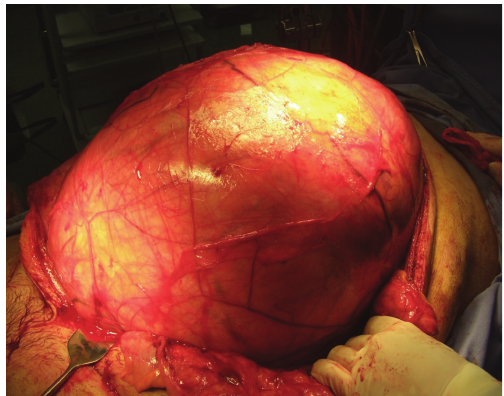
Figure 3: Intra-operative findings. The retroperitoneal tumor weighing 22 kg was